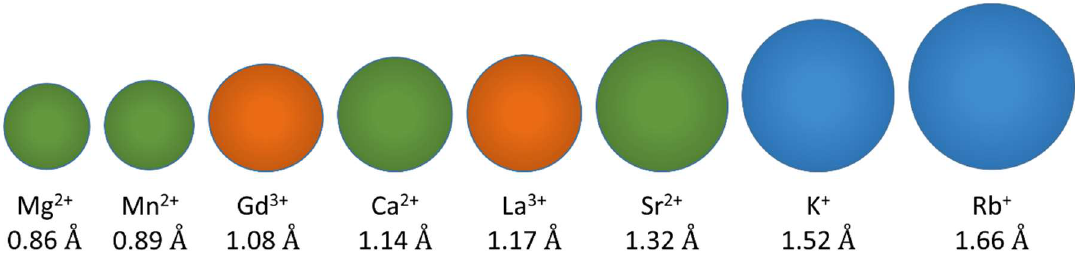
Figure 4. Relative sizes of selected monovalent, divalent and trivalent cations. Monovalent K + and Rb + shown in blue, divalent Ca 2+ , strontium (Sr 2+ ), Mg 2+ , and Mn 2+ in green, and trivalent gadolinium (Gd 3+ ) and lanthanum (La 3+ ) in orange. The sphere sizes scale with the relative ionic radii (indicated below each sphere). Ionic radii are from [100].